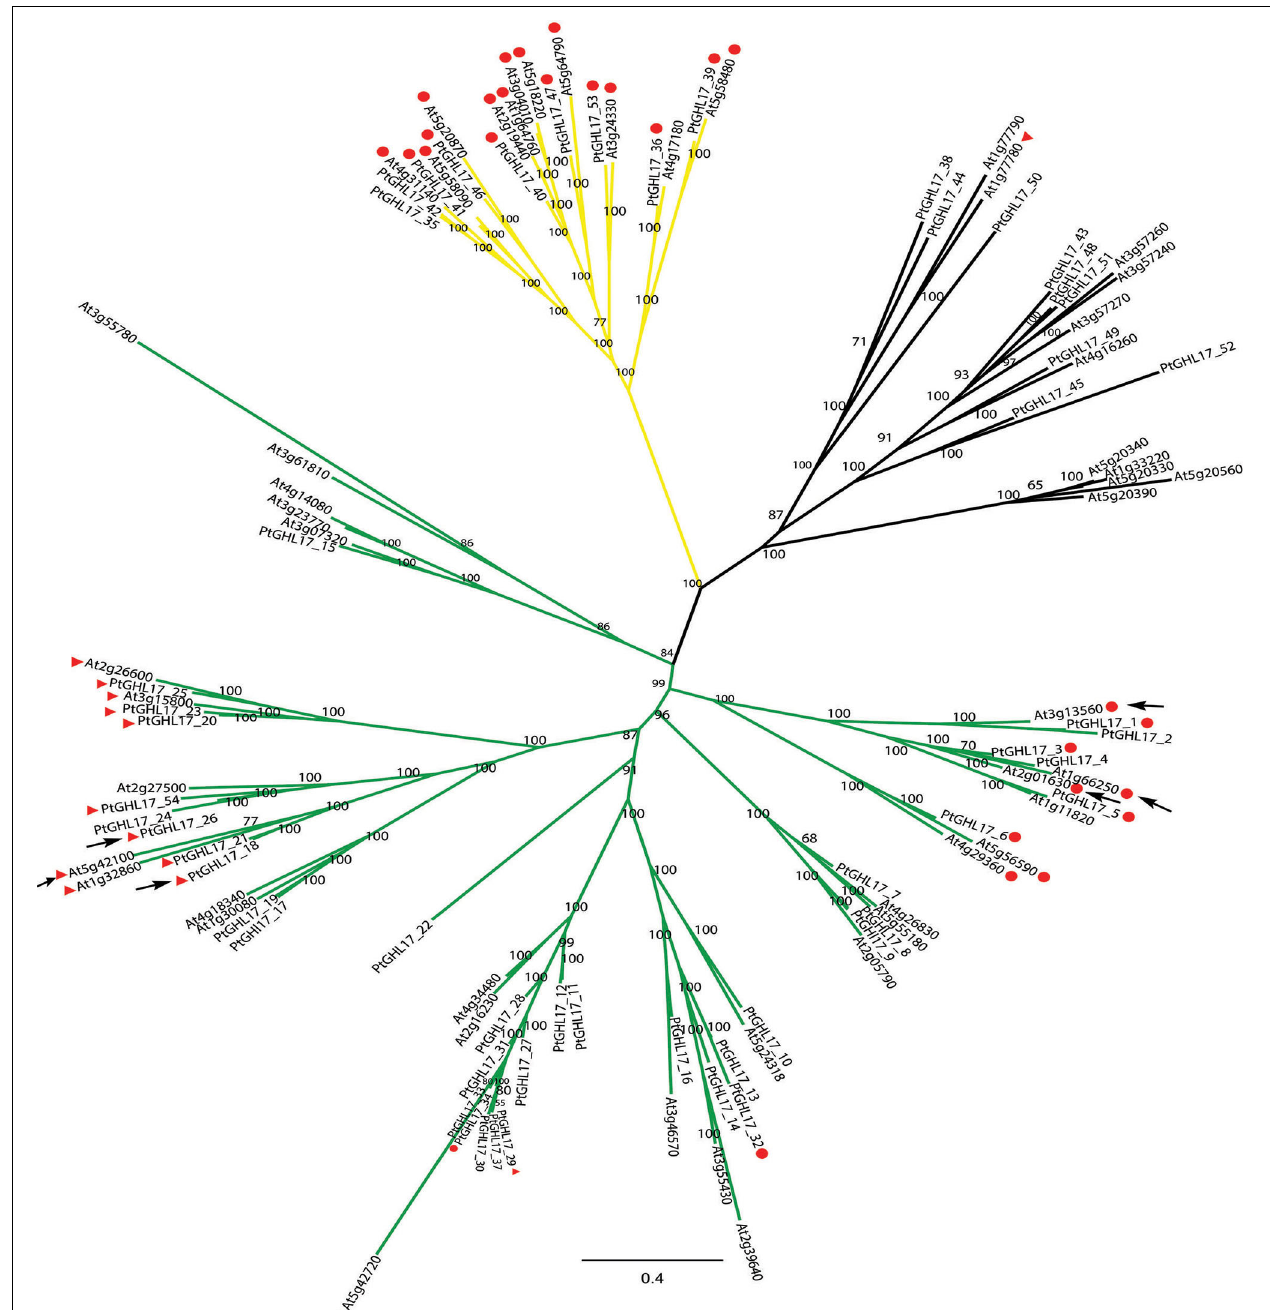
FIGURE 4 | Majority consensus tree generated by Bayesian inference of phylogeny of GHL17 proteins isolated from A. thaliana (At) and P. trichocarpa (Pt) (sequences cited in Table 1). Bayesian posterior probabilities are indicated in the tree branches. In accordance with the phylogenetic tree presented in Figure 3 , branches forming clades α (green), β